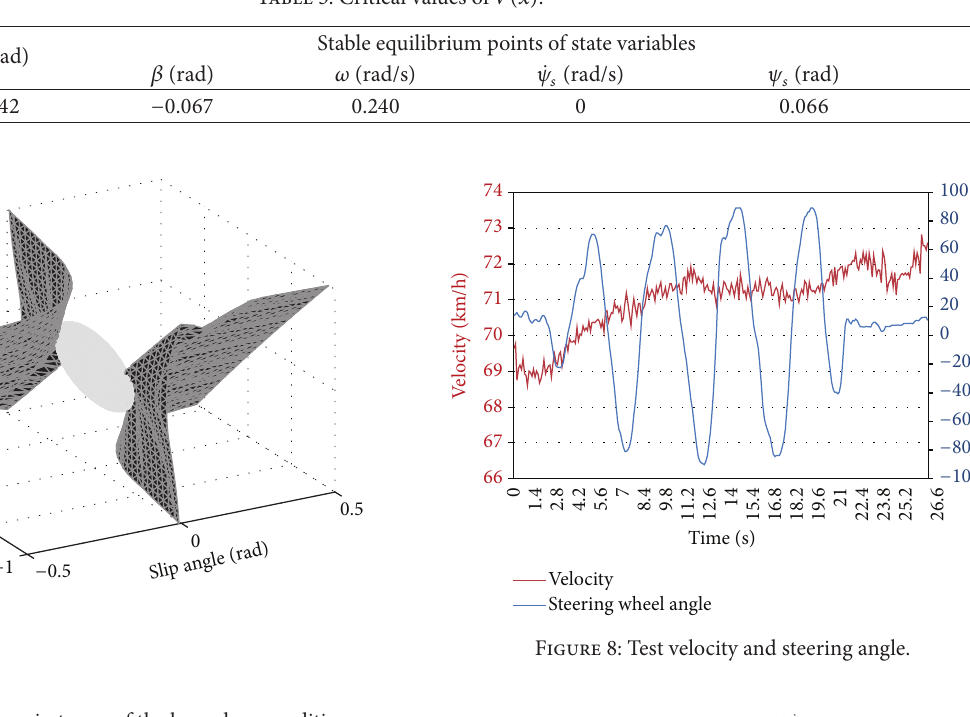
Figure 6: Critical surfaces in terms of the boundary conditions.